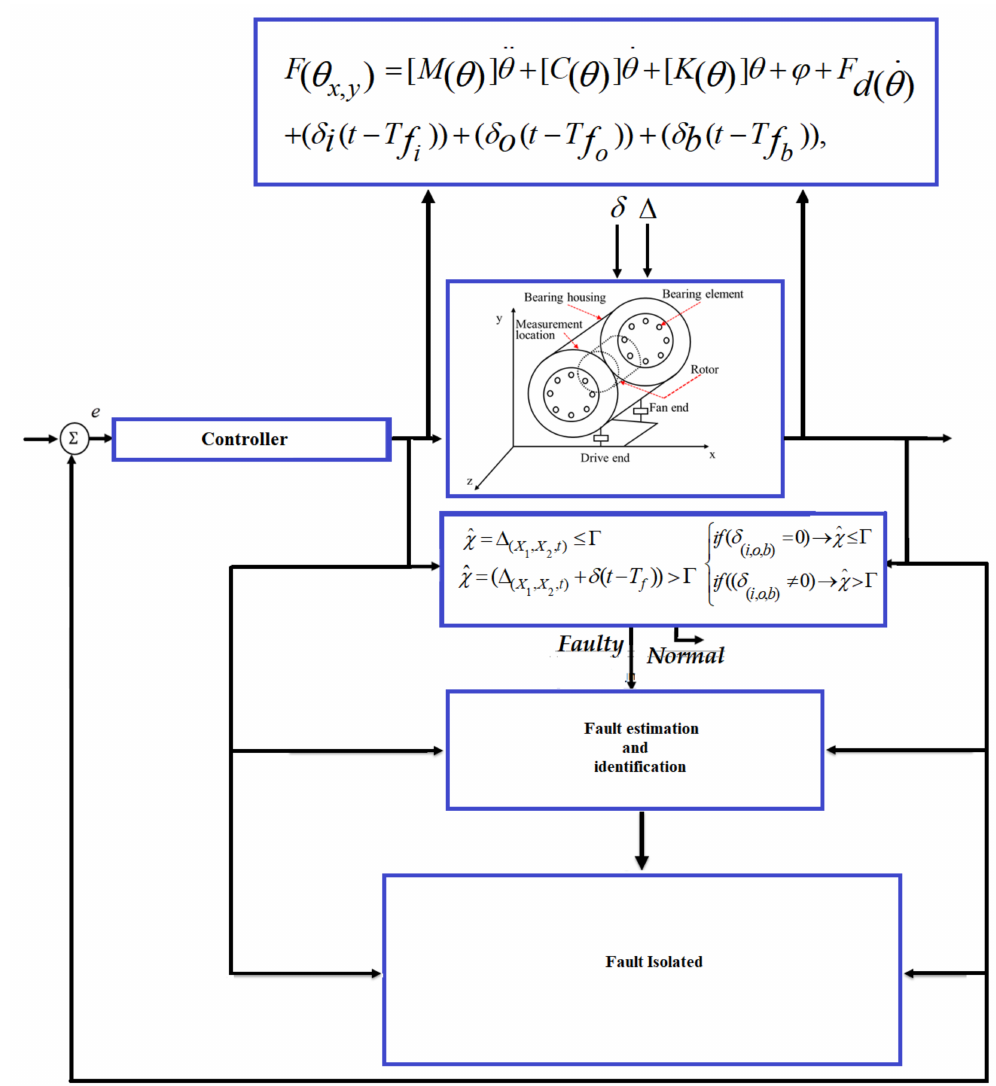
Figure 5. Block diagram of modeling and fault detection of